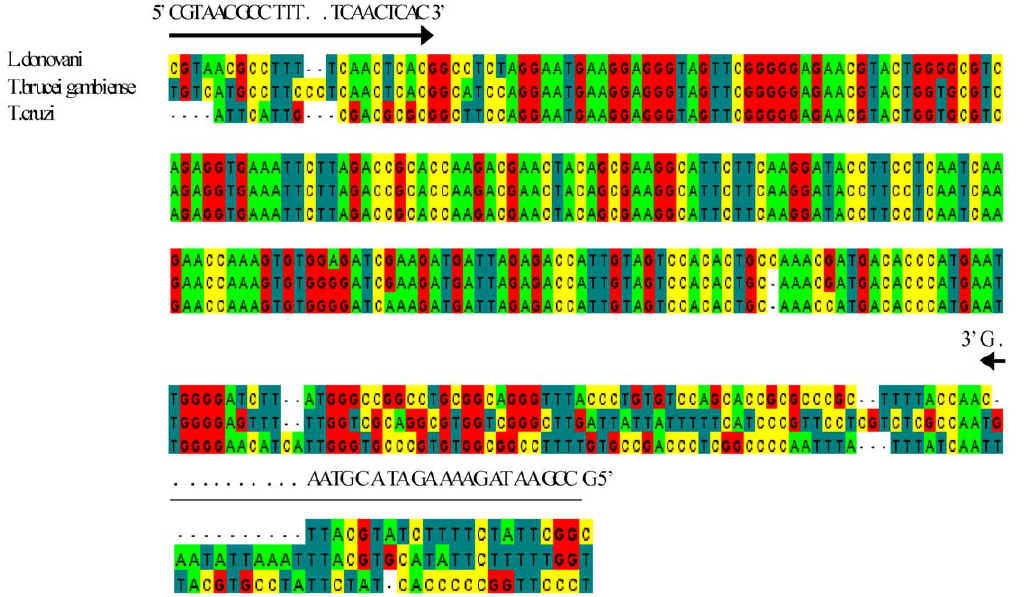
Figure 1. Sequence alignment and primer designing. Alignment of the DNA sequence within the 18S rRNA gene of Leishmania donovani ( L.d. ; GenBank accession no. X07773), Trypanosoma brucei gambiense ( T.b. ; GenBank accession no. AJ009141), and Trypanosoma cruzi ( T.c. ; GenBank accession no. AF303660). The forward (BHUL18SF) and reverse (BHUL18SR) primers are indicated by arrows.